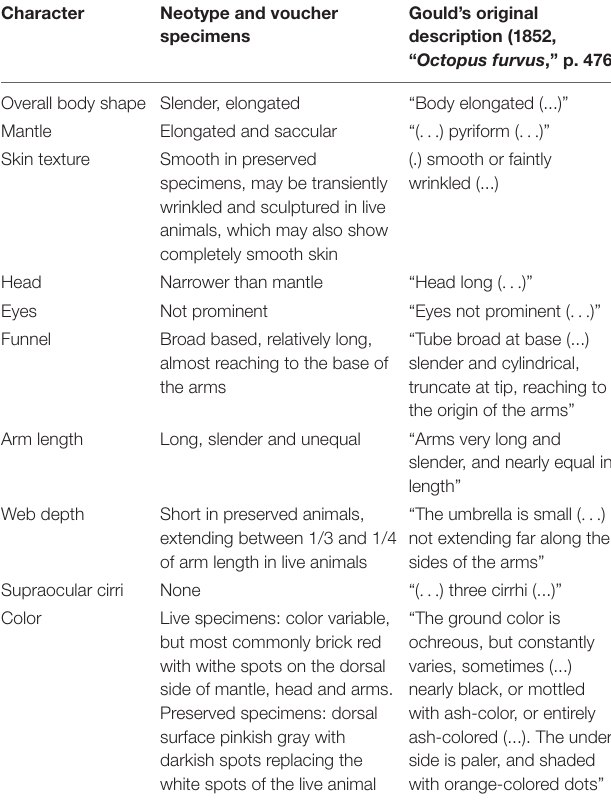
with withe spots on the dorsal side of mantle, head and